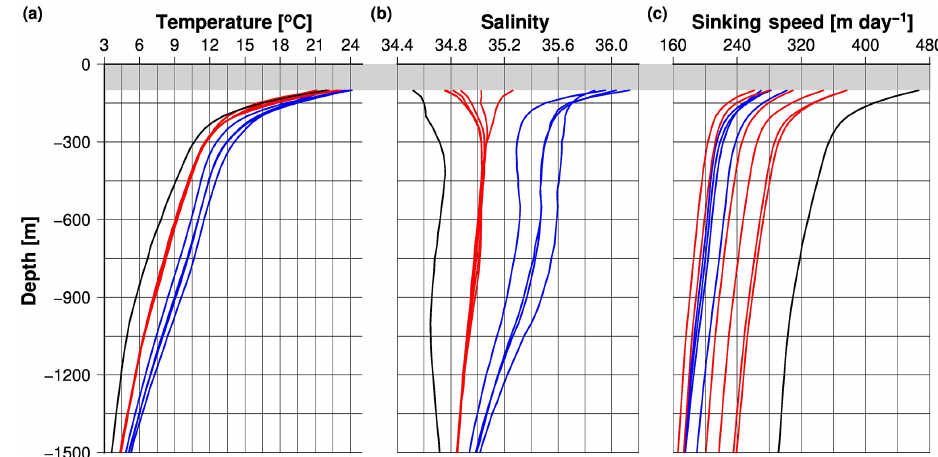
Figure 5. Seawater temperature (a) and salinity profiles (b) selected from the World Ocean Atlas 2013 for the trap site. (c) Speed of sinking material derived from the seawater properties (Eqs. 7–9) and the density of the solid (see Eq. 6). The grey bar indicates a water depth of <100m. Black, red and blue lines represent the trap site JAM and the trap sites in the Bay of Bengal and the Arabian Sea.